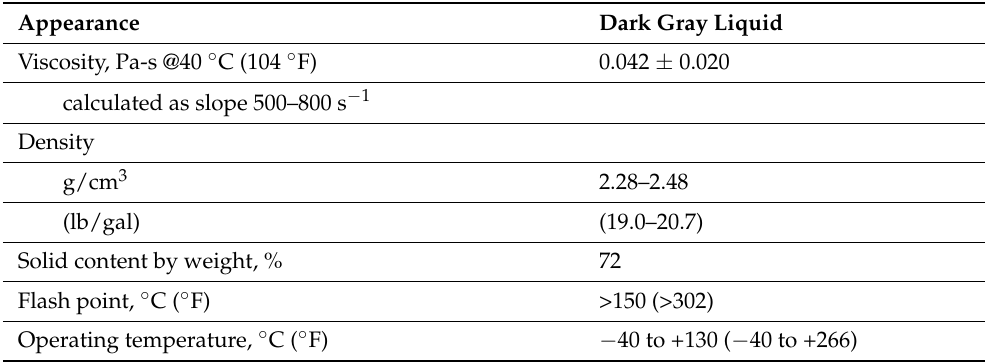
Table 1. Typical properties of MRF 122EG